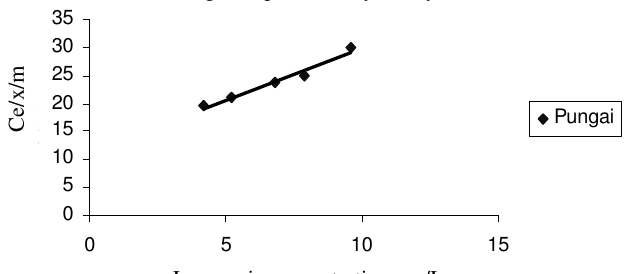
Figure 6. Langmuir isotherms for adsorption of Grey BL on Derris leaf powder at 300 K with dye concentration of 50 mg/L and agitation time 5